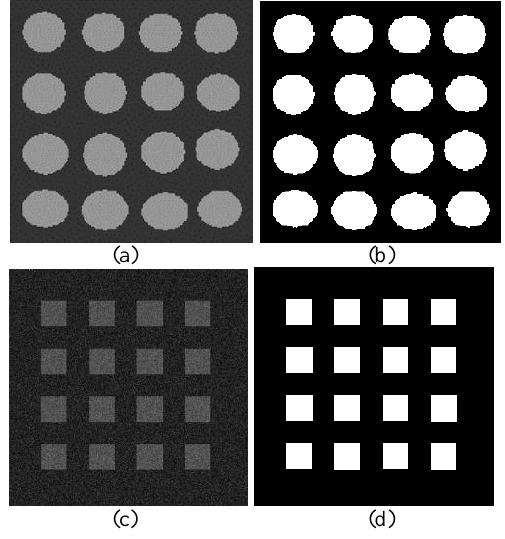
Fig. 5. Image and its ground-truth: (a) Circle; (b) Ground-truth of circle; (c) Square; (d) Ground-truth of